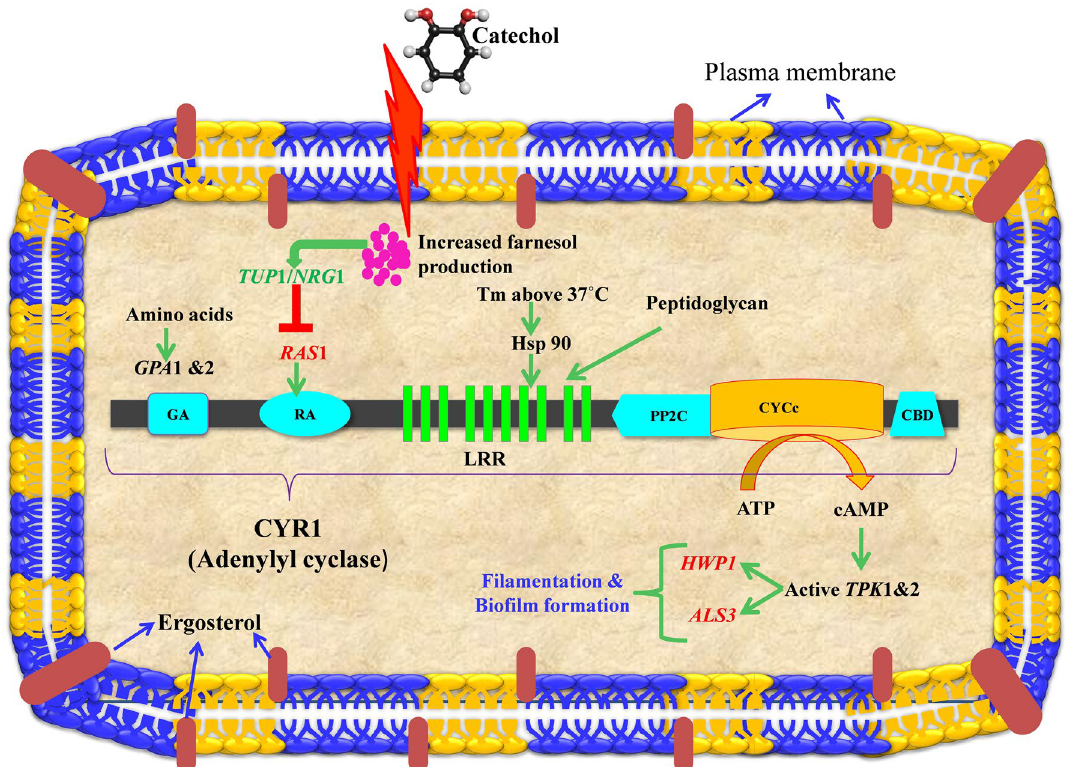
Figure 17. Schematic illustration of differential expression of genes involved in C. albicans Ras-cAMP-PKA pathway during catechol exposure. Unregulated and down regulated genes were indicated using red and green colored arrow,